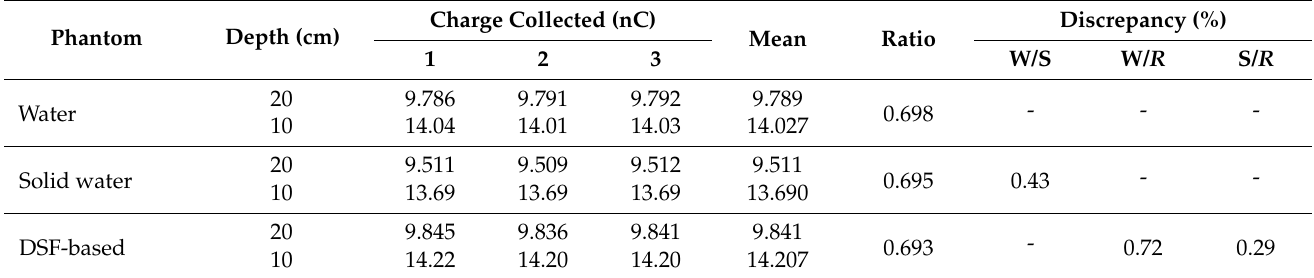
Table 6. TPR 20,10 measurement for DSF/NaOH/IA-PAE/ R. spp. particleboards (sample A 15 ), water, and solid water phantoms for 6 MV photons.